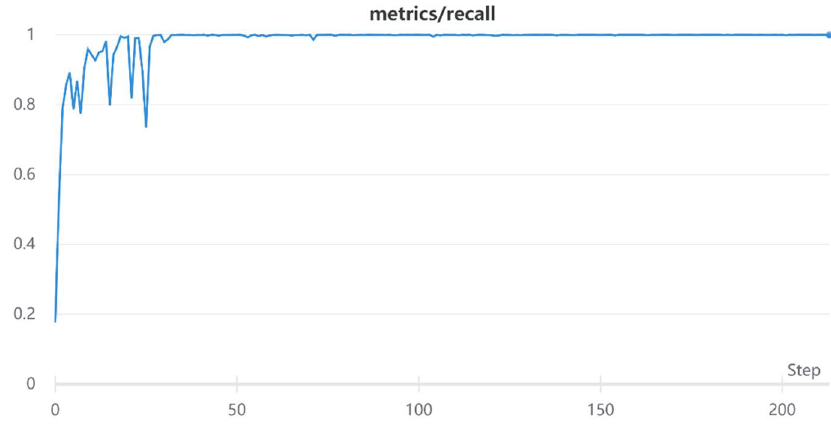
Figure 14. Training-process curves.